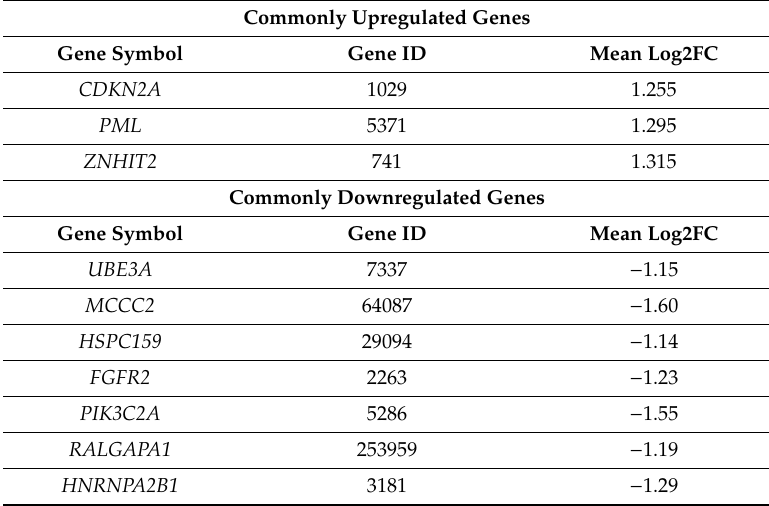
Table 4. Common telomere- and telomerase-associated upregulated and downregulated genes in diseased mid-secretory phase endometrium compared with normal mid-secretory phase endometrium.